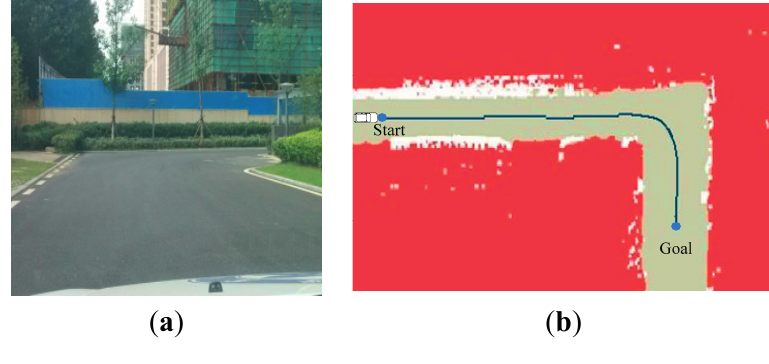
Figure 10. The experiment result in scenario 1. ( a ) shows a 90 degree turn in the zone; ( b ) shows the path generation